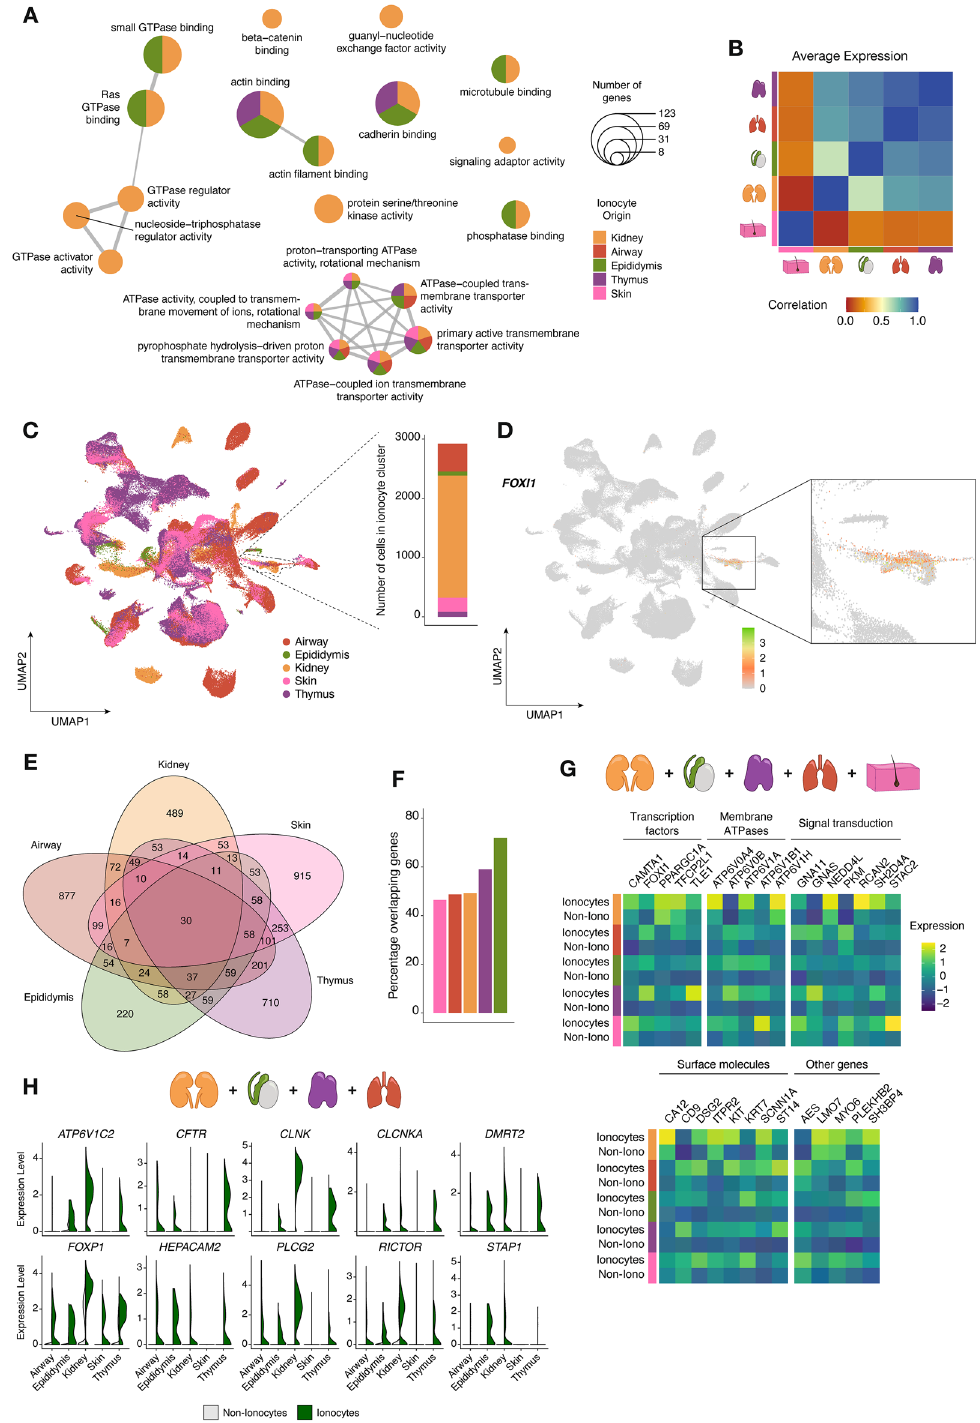
Figure 3. Human ionocytes derived from kidney, airway, epididymis, thymus, and skin are functionally and transcriptionally very similar. ( A ) Enrichment map depicting the most highly enriched biological processes based on the differentially expressed genes (DEGs) in each ionocyte population. ( B ) Correlation heatmap of average gene expression between ionocytes found in thymus, airway, epididymis, kidney, or skin. The correlation coefficient indicates the results of a Pearson’s correlation test. ( C ) Uniform Manifold Approximation and Projection (UMAP) plot outlining the integration of five whole-tissue human datasets. The traced cell cluster indicates the ionocyte cluster, and the bar graph shows the number of cells comprising this cluster derived from each organ. ( D ) Feature plot showing relative FOXI1 expression in the ionocyte cluster. ( E ) Venn diagram illustrating the shared DEGs between the five ionocyte populations. ( F ) Bar graph indicating the percentage of overlapping genes between each ionocyte population and the rest. ( G ) Heatmaps depicting the relative expression levels of the 30 shared DEGs between ionocytes and non-ionocytes per tissue of origin. ( H ) Violin plots of exemplar DEGs shared between kidney, epididymis, thymus, and airway